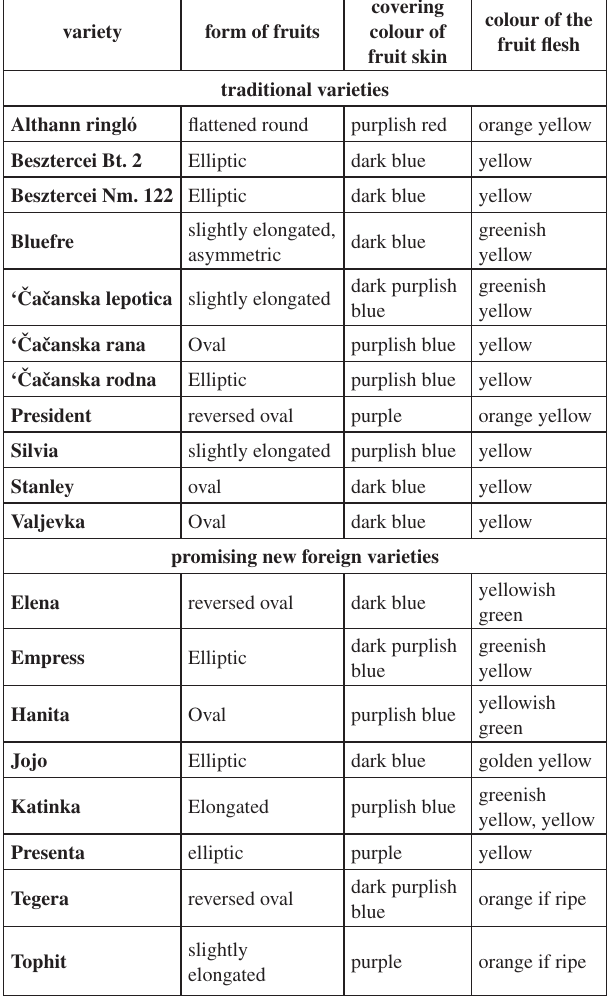
Table 2. Main morphological traits of fruits in plum